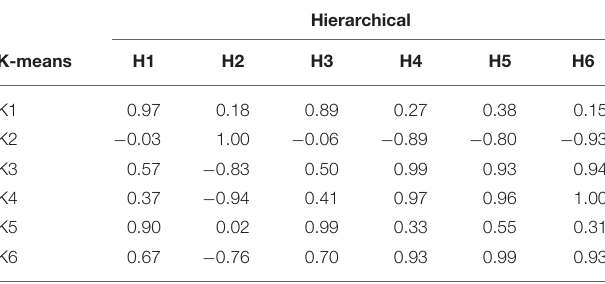
TABLE 3 | Inter-correlation matrix of the hierarchical and K-means clusters ( n = 2,364).